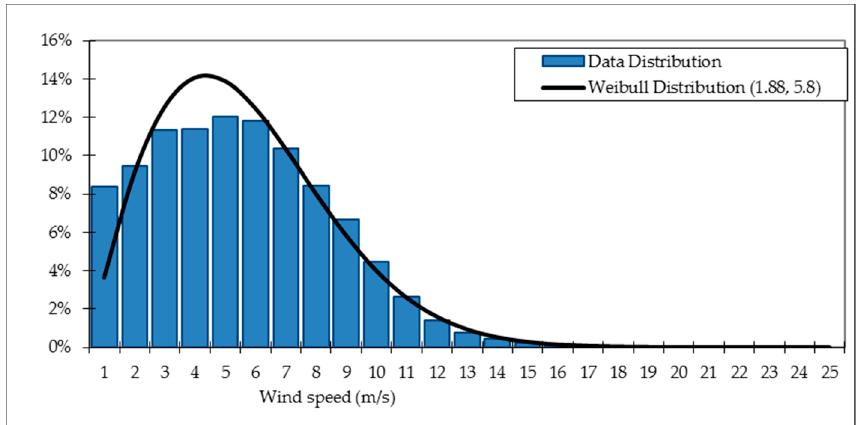
Figure 2. Histogram of the wind speed and the approximated Weibull distribution.